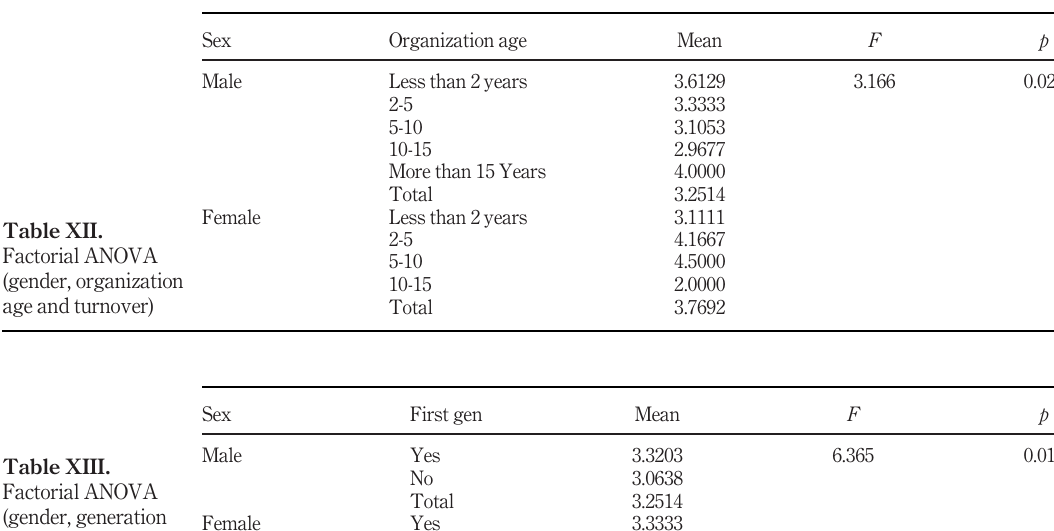
Table XIII. Factorial ANOVA (gender, generation of entrepreneurship and